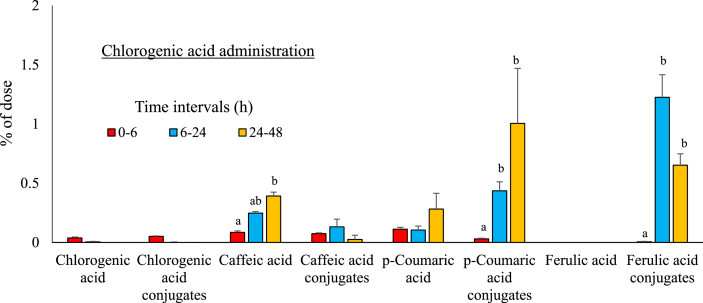
The urinary excretion rate (% of the dose) of chlorogenic acid after oral administration to non-fasted rats. The data represent the mean ± SE (n = 4). Forty mg/kg BW of chlorogenic acid was gavaged to the non-fasted rats. The rats were fed the AIN-93M diet throughout the experiment. The urine was collected at time intervals of 0–6 h, 6–24 h, and 24–48 h after chlorogenic acid administration. The total excretion amount was 0.4% at 0–6 h, 2.2% at 6–24 h, and 2.4% at 24–48 h. The different letters indicate statistically significant differences (P < 0.05).